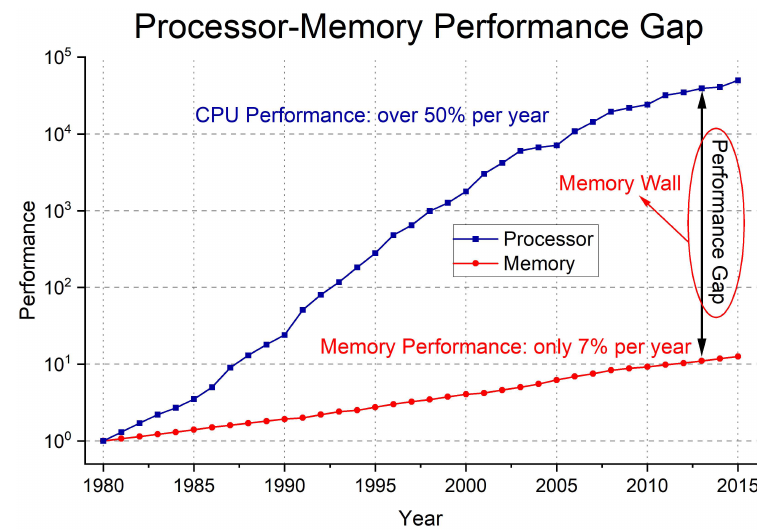
Figure 3. Performance gap of processor and memory from 1980s.